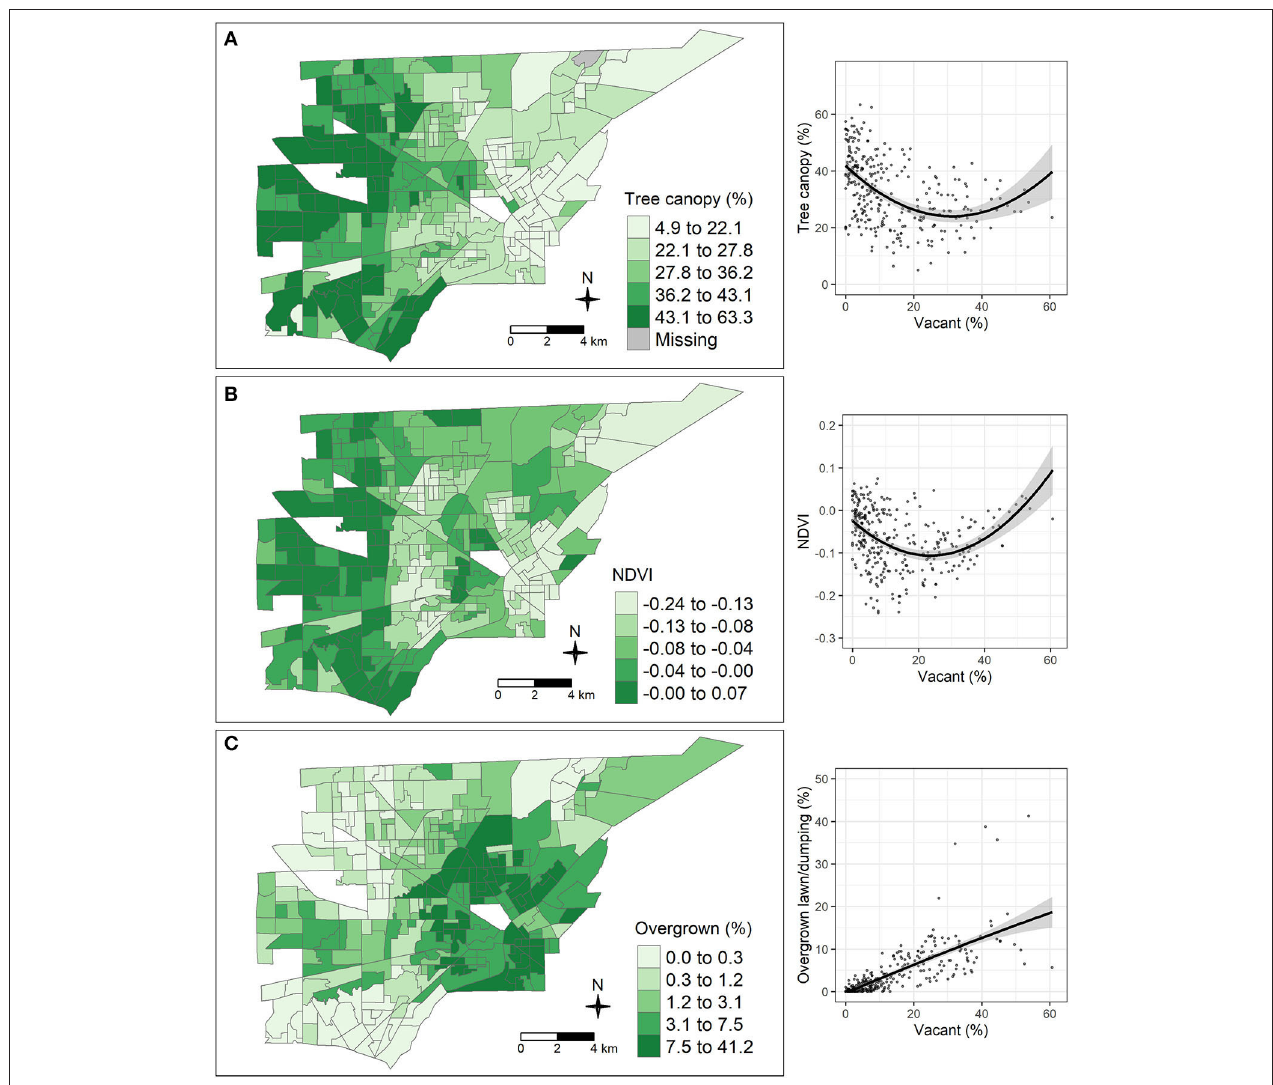
FIGURE 2 | Maps of greenness indicators and their respective relationships with percent vacant parcels (vacant structures plus vacant lots) within Toledo block groups. On the maps, filled polygons represent census block groups with ≥ 20 residential parcels. Within each block group, (A) tree canopy represents the mean percent canopy cover for all residential parcels, (B) NDVI represents the mean parcel NDVI value, and (C) overgrown lawn and/or dumping represents that percent of parcels noted as such during the Toledo Survey. On the scatterplots, block groups are represented by points, and quadratic regression lines are displayed because they yielded a better fit than linear